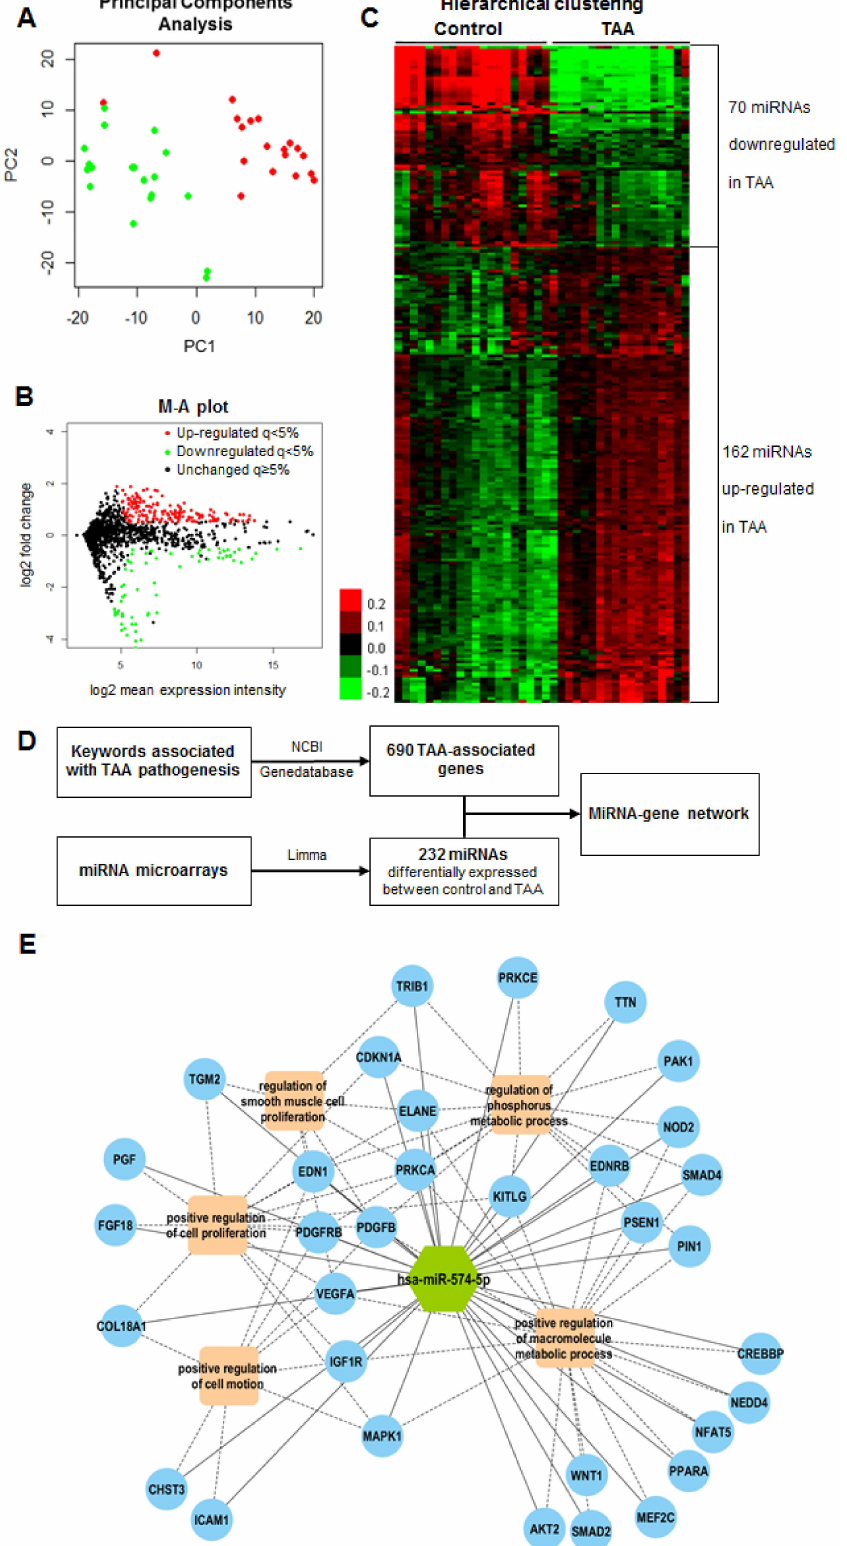
Figure 1. MicroRNAs (MiRNA) expression profiles in aortic tissues from the tissue cohort and miRNA-gene and protein-protein interaction network. ( A – C ). Microarrays were conducted on RNA